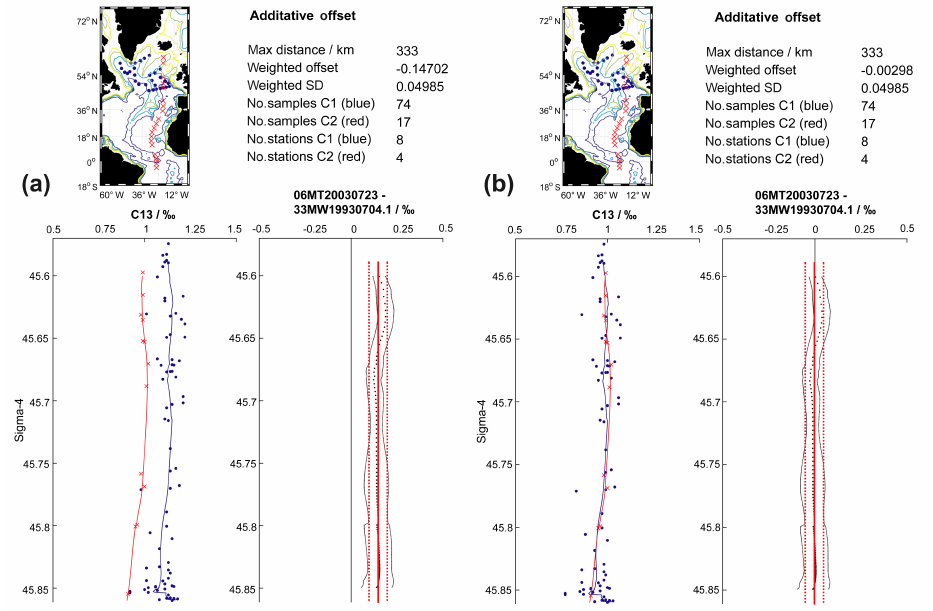
Figure 3. Crossovers between cruise 06MT20030723 (blue dots and lines) and the core cruise 33MW19930704-1 (red crosses and lines). The C13 plots show the data and mean profiles of each cruise, and the difference plots show the difference profiles with their standard deviation (black lines) as well as the crossovers offset with their standard deviation (red lines). The left-hand plot shows the original, and the right hand plot the adjusted data. In both cases the distribution of the δ 13 C-DIC on equal density surfaces (left-hand side) as well as the mean offset between both cruises (right-hand side) is shown. Cruise 06MT20030723 was adjusted by −